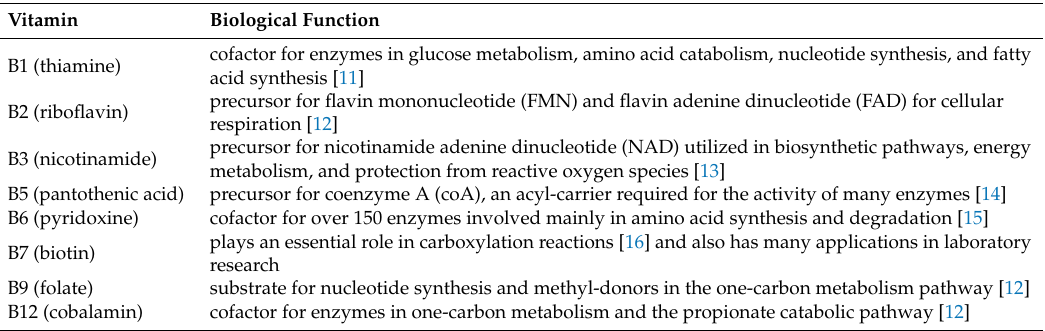
Table 1. Biological roles of the B